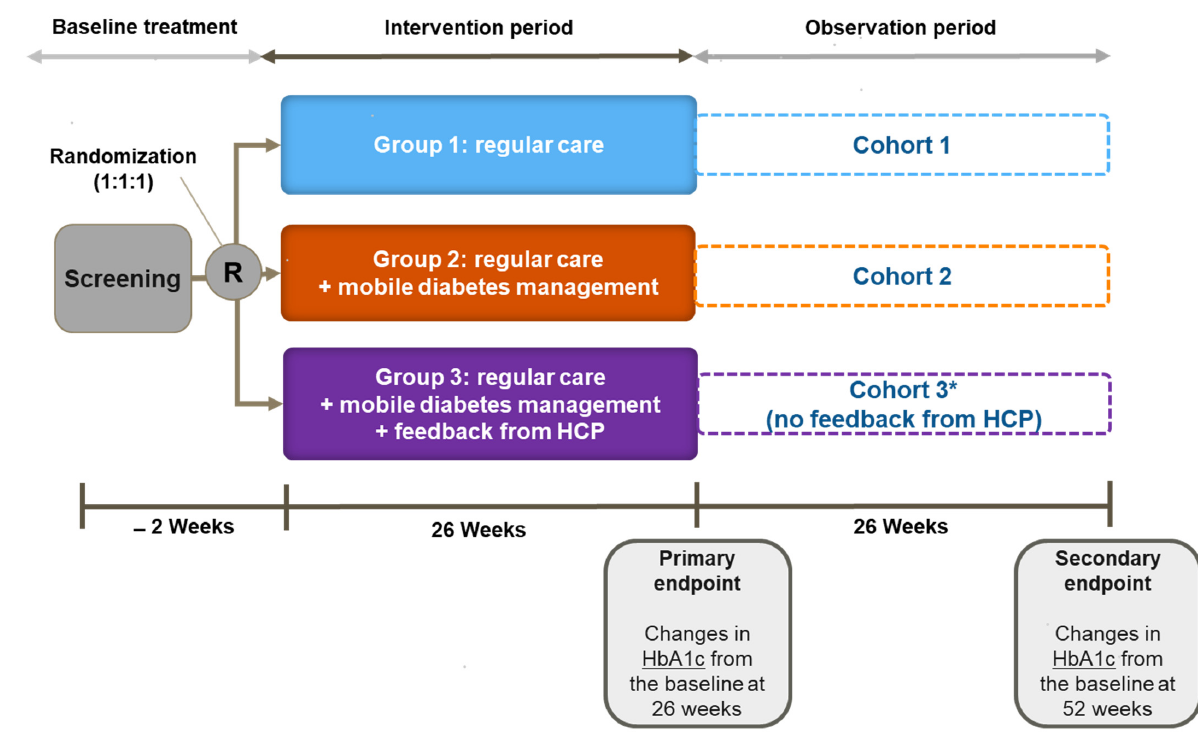
Figure 2. Schematic diagram of the study protocol. HCP: healthcare professional; R: randomization. * No feedback from HCP in Group 3 during the observation period.